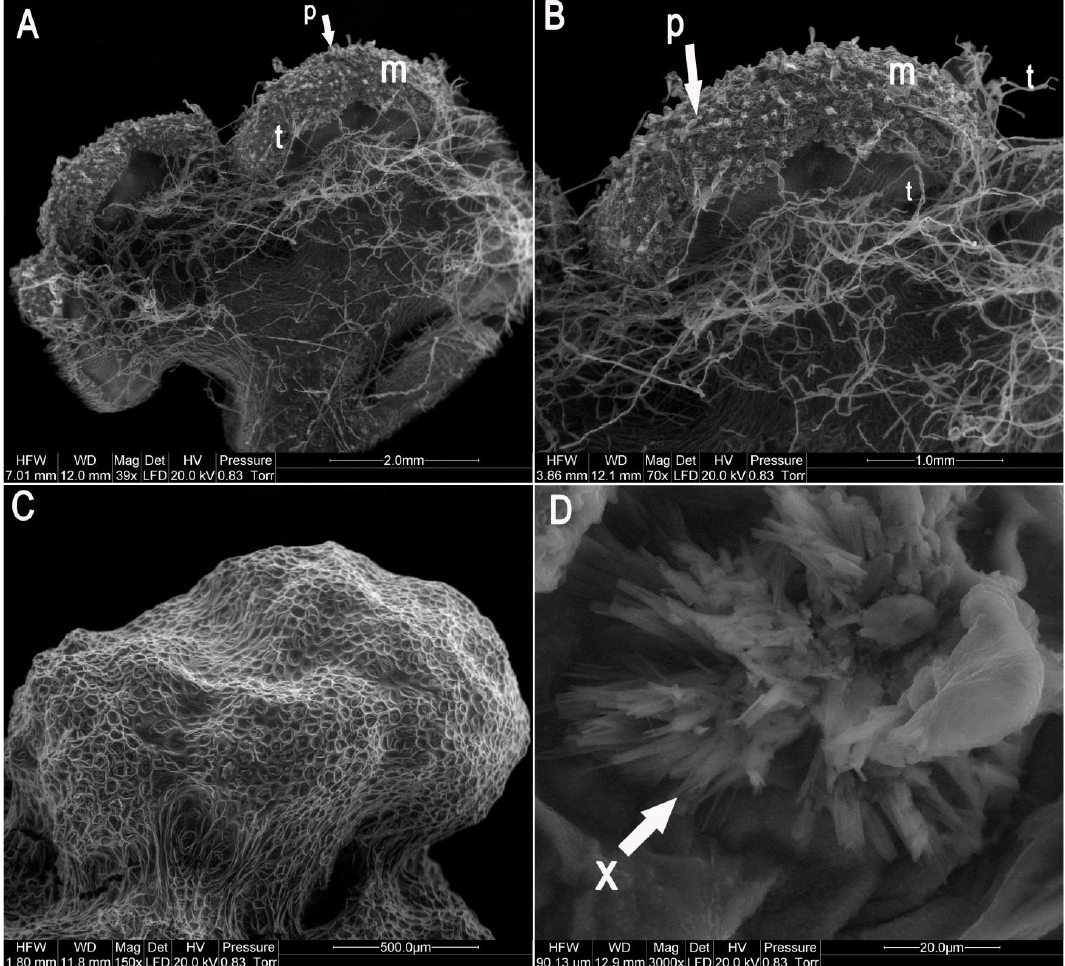
Figure 4. Development of the mature phase and adult gametophytes using SEM microscope. ( A ) Dorsal and ventral view of an adult, heart-shaped gametophyte. ( B ) Magnification ventral view of the same gametophyte. Detail of the notch showing meristematic cells with meristematic zone (m) and embedded in the epidermis antheridia with numerous sterile paraphyses (p). In most of the gametophytes numerous trichomes covered the ventral surface (t), but some prothallus ( C ) did not develop gametangia and their ventral surface was devoid of trichomes. ( D ) An orange-colored crystallized secretion at the base of the ventral surface of prothallus (X).